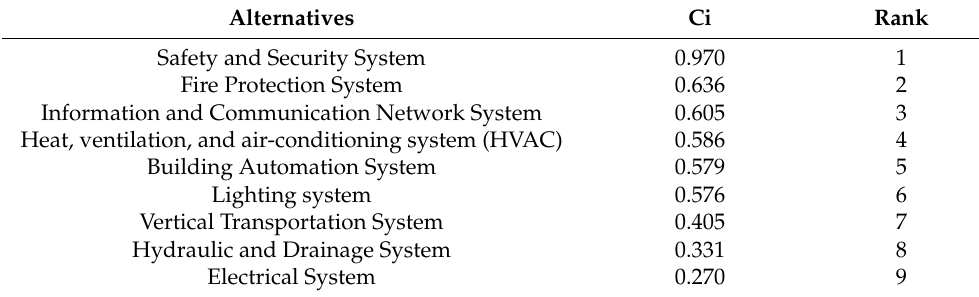
Table 4. Fuzzy-TOPSIS ranking of smart building technologies in